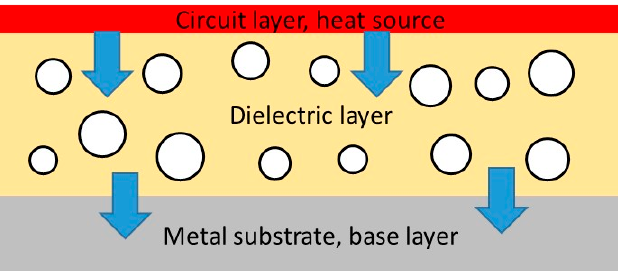
Figure 1. Schematic illustration of an insulated metal substrate (IMS).